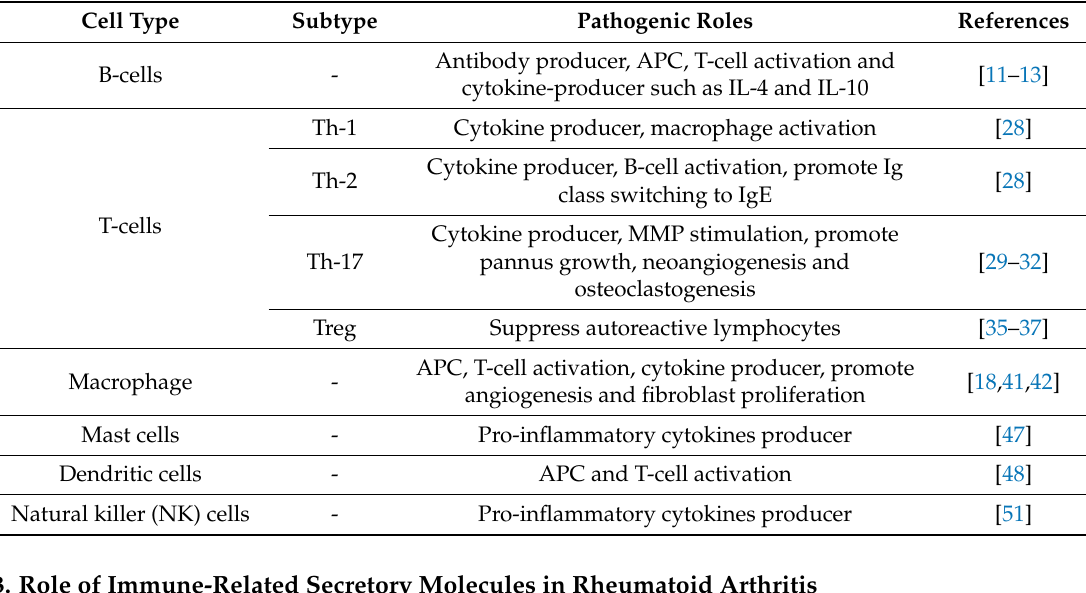
Table 1. Contribution of immune cells to Rheumatoid Arthritis (RA) and their potentials as therapeutic